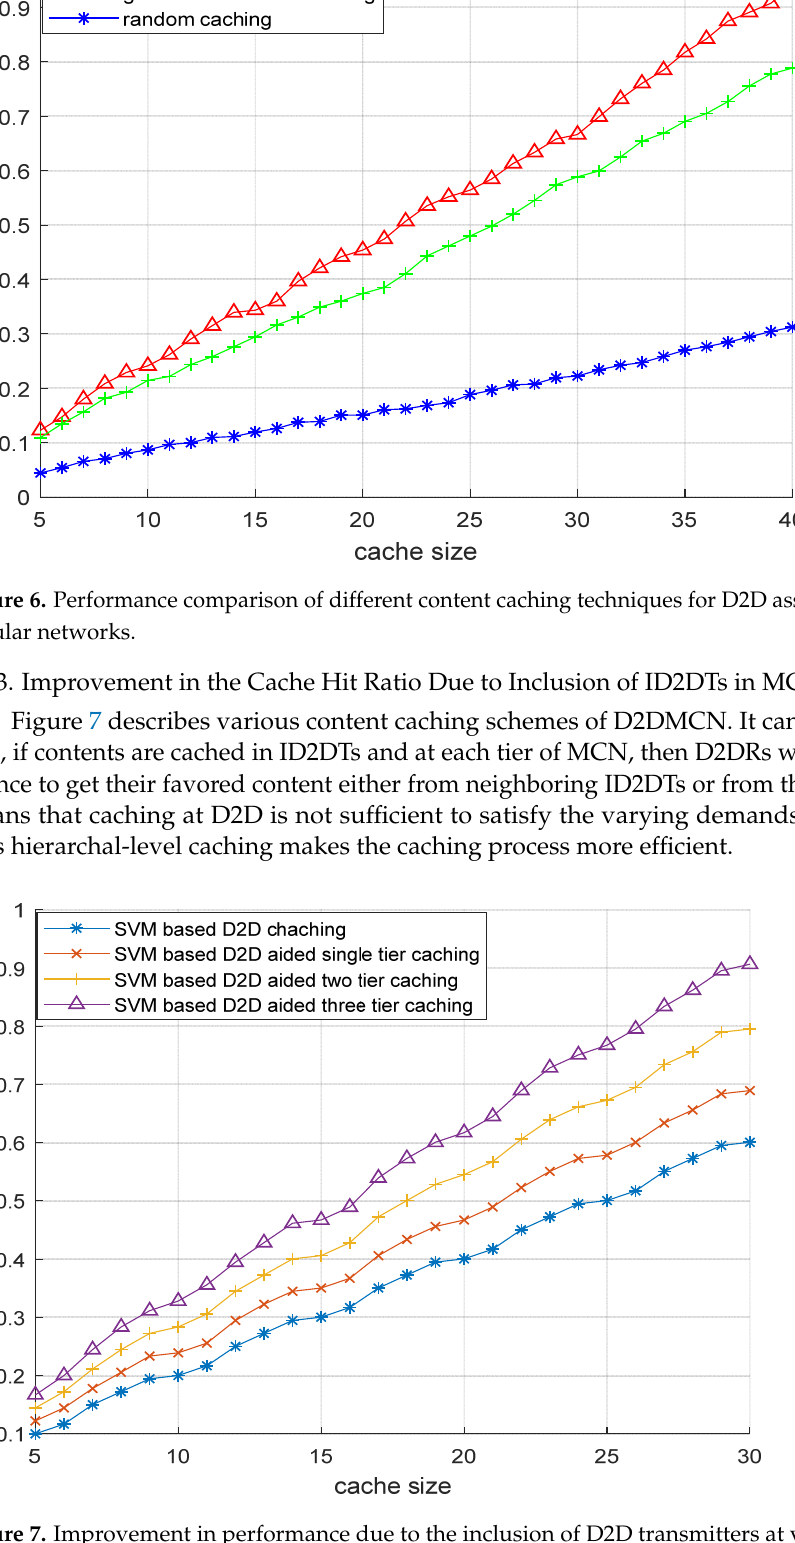
Figure 7. Improvement in performance due to the inclusion of D2D transmitters at various tiers of multitier cellular network.